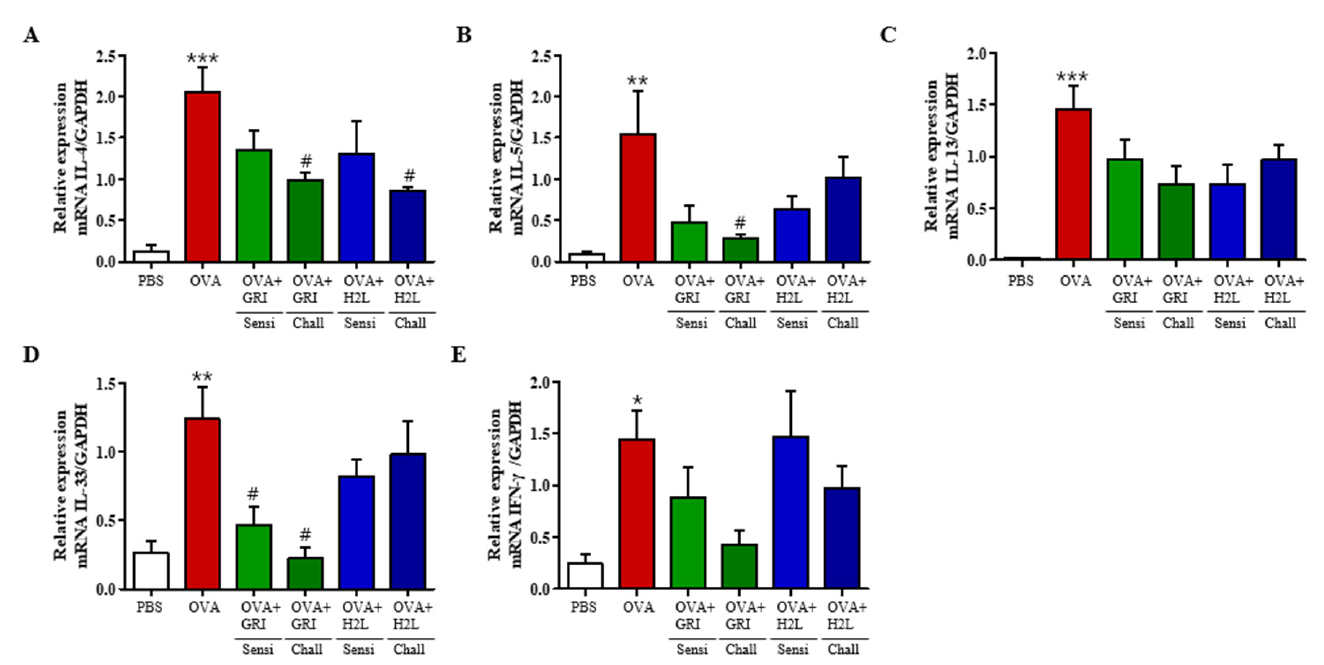
Figure 6. H2L5186303 and GRI977143 inhibit the mRNA expression of cytokines in the lungs. Analysis of mRNA expression of the Th2 cytokines IL-4, IL-5, IL-13, Th1 cytokine IL-33, and IFN- γ in lung tissues. ( A ) IL-4, ( B ) IL-5, ( C ) IL-13, ( D ) IL-33, and ( E ) IFN- γ . The relative mRNA levels of cytokines were quantified with respect to glyceraldehyde-3-phosphate dehydrogenase (GAPDH) as the housekeeping gene. Values are presented as the mean ± standard error (SE) ( n = 5). * p < 0.05, ** p < 0.01, *** p < 0.001 vs. the PBS-treated group, # p < 0.05 vs. the OVA-treated group. 2.6. GRI977143 and H2L5186303 Treatments Suppressed OVA-Induced Elevated IL-13 Levels